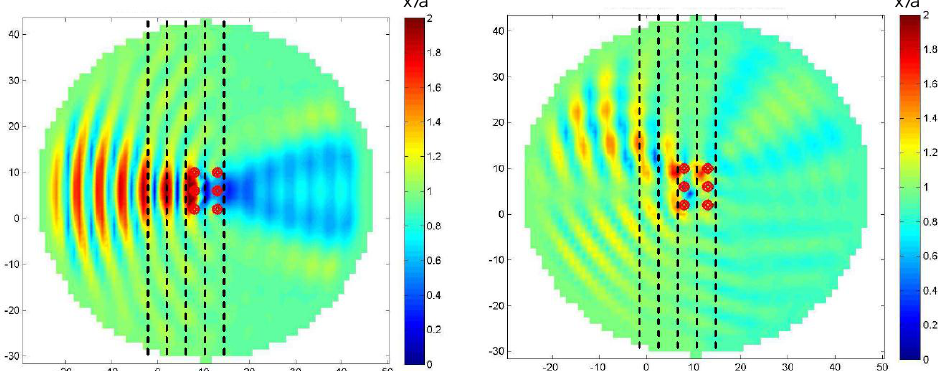
Figure 14. Total field of the WEC array for ( a ) normal and ( b ) 45 degrees incidence (right) and (cid:112) (cid:112) h m / g = 1.5, ω a / g = 0.8, in the variable bathymetry region (dashed lines represent depth ω contours). The colorbar indicates relative intensity of the